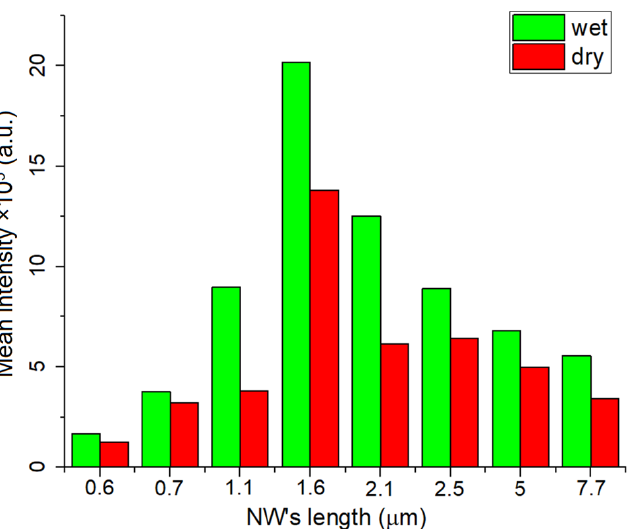
Figure 6. SERS-spectra of 10 µ g/mL 4-MPBA adsorbed on the “dry” and “wet” substrates with Figure 6. SERS ‐ spectra of 10 μ g/mL 4 ‐ MPBA adsorbed on the “dry” and “wet” substrates with Ag ‐ Ag-NWs with a diameter of 100 nm collected in 1571 cm − 1 NWs with a diameter of 100 nm collected in 1571 cm − 1 .